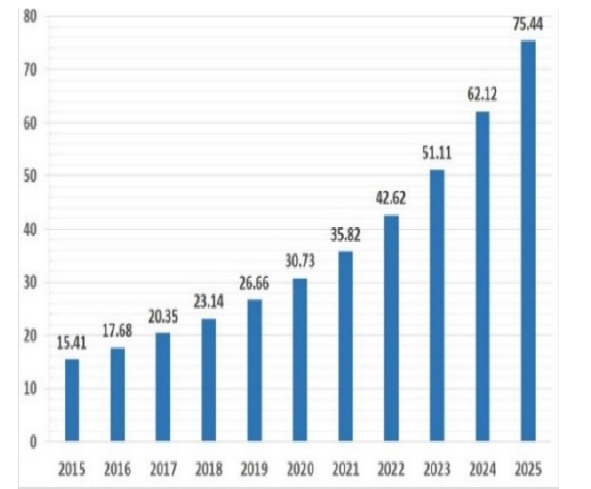
Fig. 1 : Forecasting of IoT Devices Growth Source: IHS.